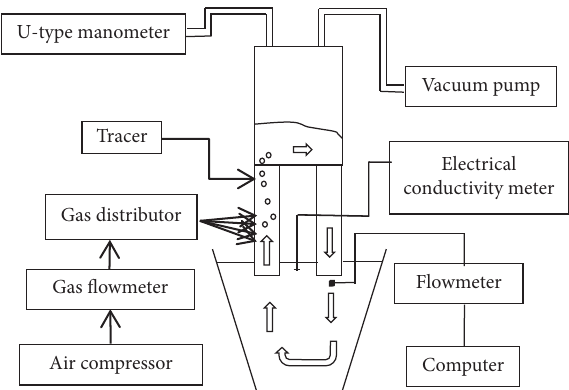
Figure 2: Schematic of water Table 3: Parameters of the prototype and water model.